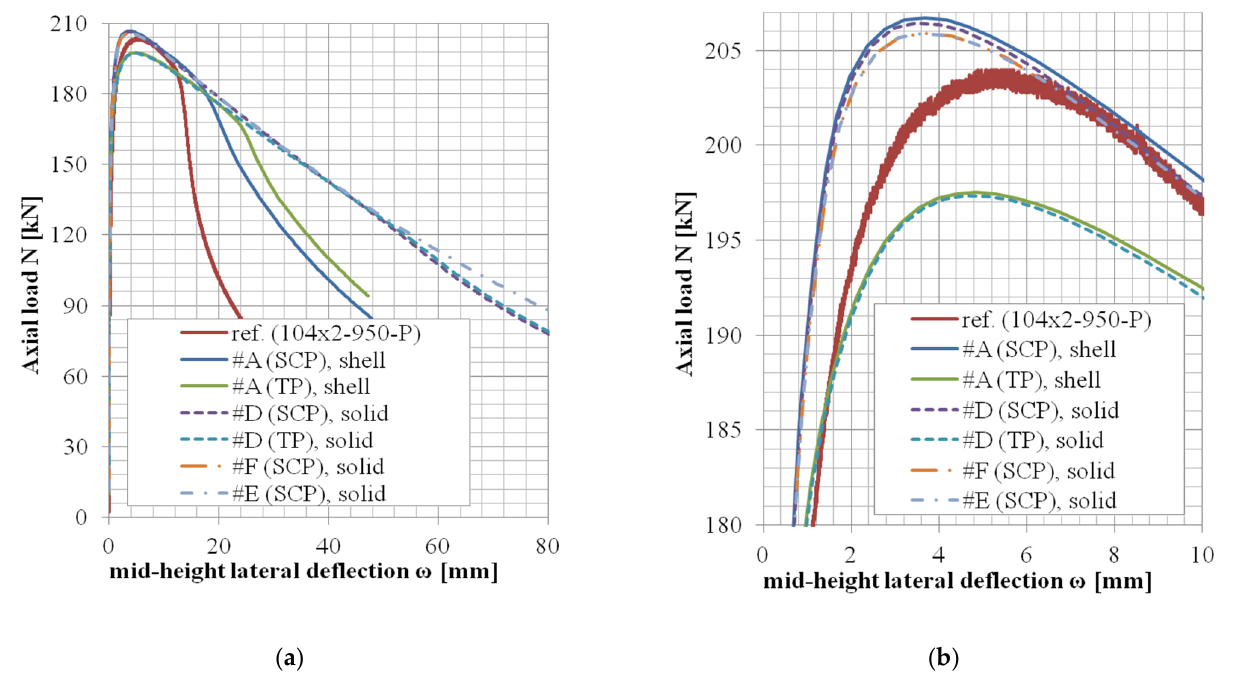
Figure 10. Experimental and FE load vs. midheight lateral deflection curves of 104 × 2-950-P [38]: ( a ) whole*; ( b ) zoomed.